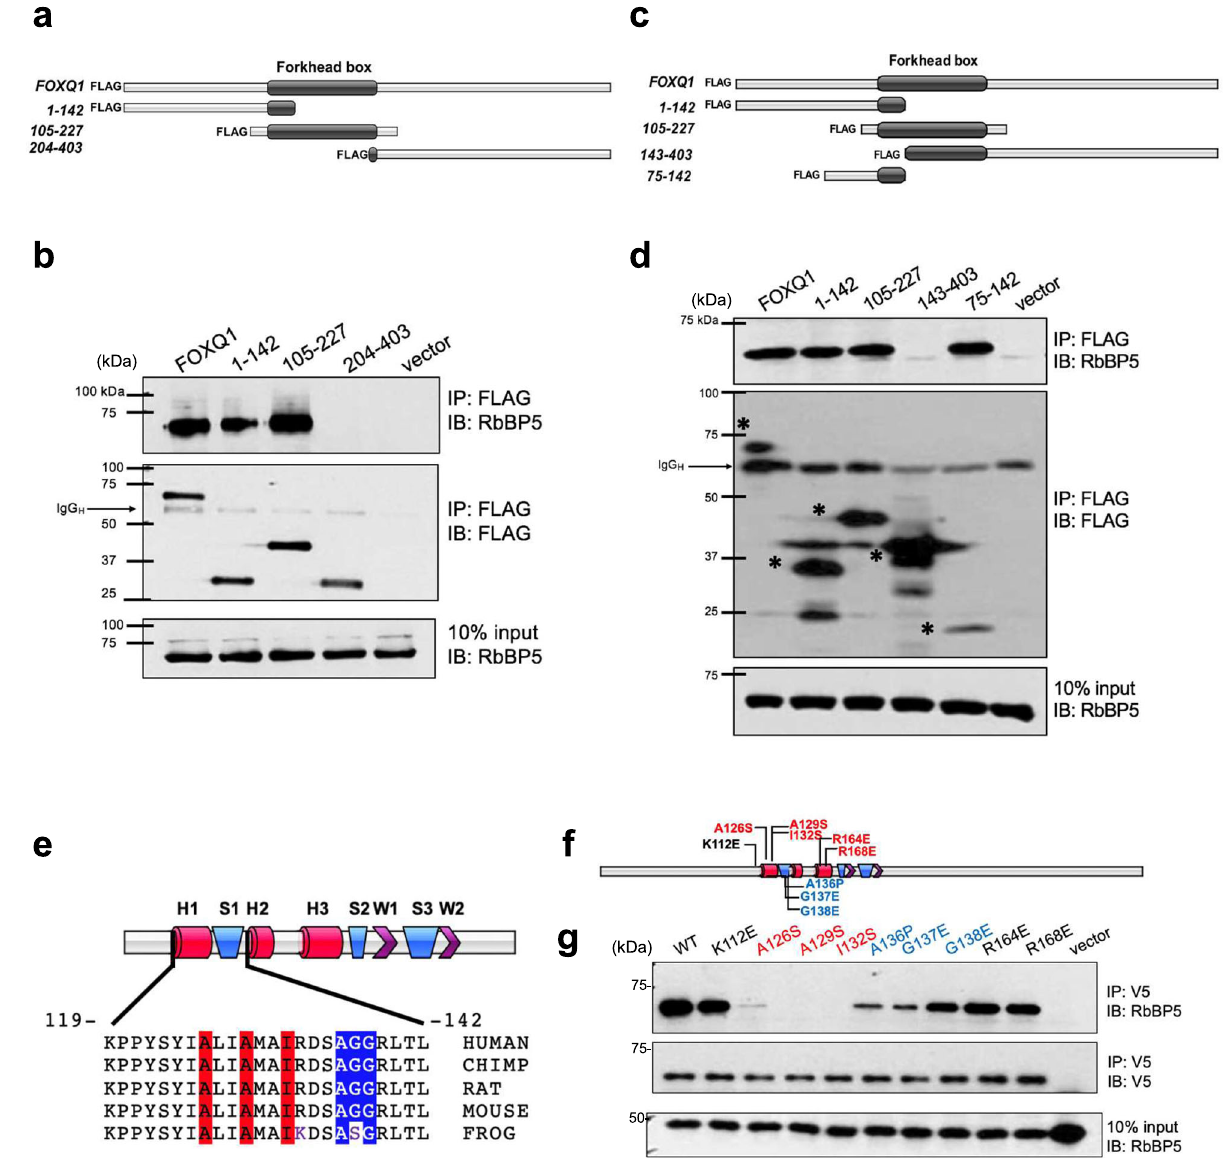
Fig. 4 | FOXQ1binds toRbBP5within theForkheadboxdomain.a Schematicof the FOXQ1 fragment subcloning. N-terminal (1-142), Forkhead box (105-227), and C-terminal (204-403) were fused to FLAG-tag. b Fragments were transfected into HEK293 cells with full-length FOXQ1 and vector control. Lysates were subject to IP with anti-FLAG resin and analyzed by western blot with an antibody against endo- genous RbBP5. c Schematic of constructs designed to narrow the domain of interaction within FOXQ1., Additional constructs of the FOXQ1 N-terminal frag- ments(1 – 142)andtheForkheadboxfragment(105-227)weretransfectedalongside C-terminalresidues142 – 403andN-terminal75 – 142tore fi netheregionresponsible for the RbBP5 interaction. d IP western blot analysis with membranes probed with